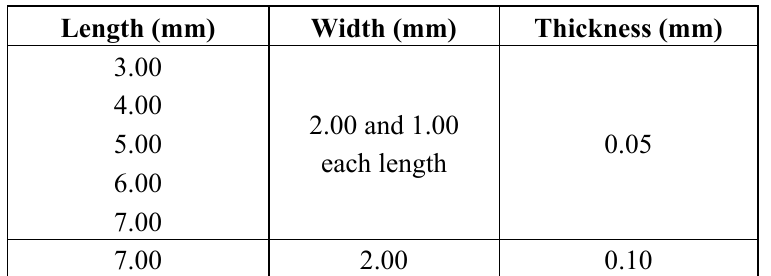
Table 1. Geometries of the tested oscillators.